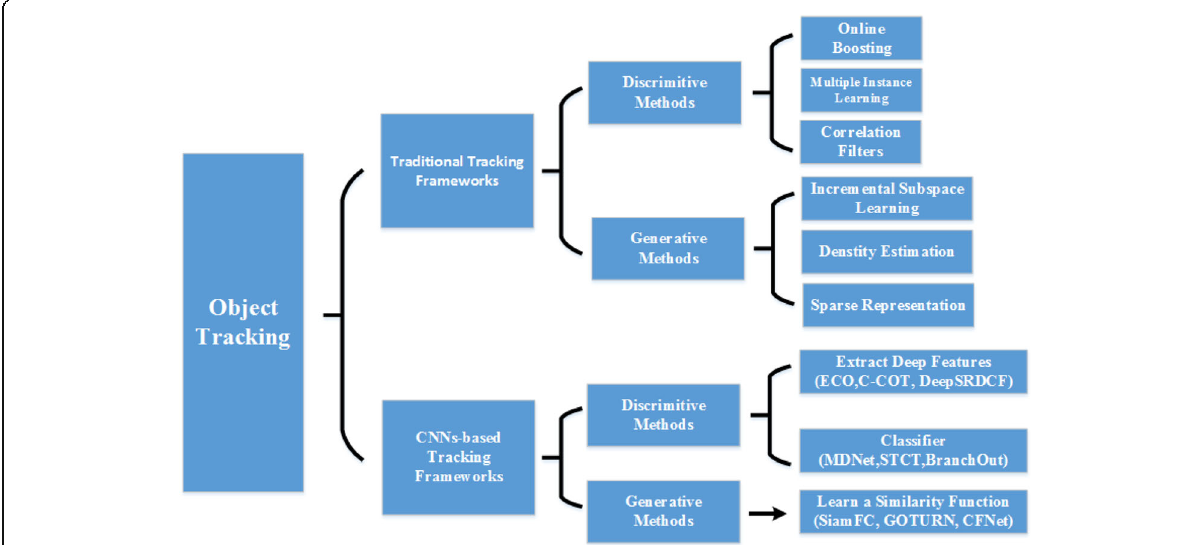
Fig. 1 The logical flowchart of the object tracking. The logical flowchart is used to clearly introduce the development of the object tracking